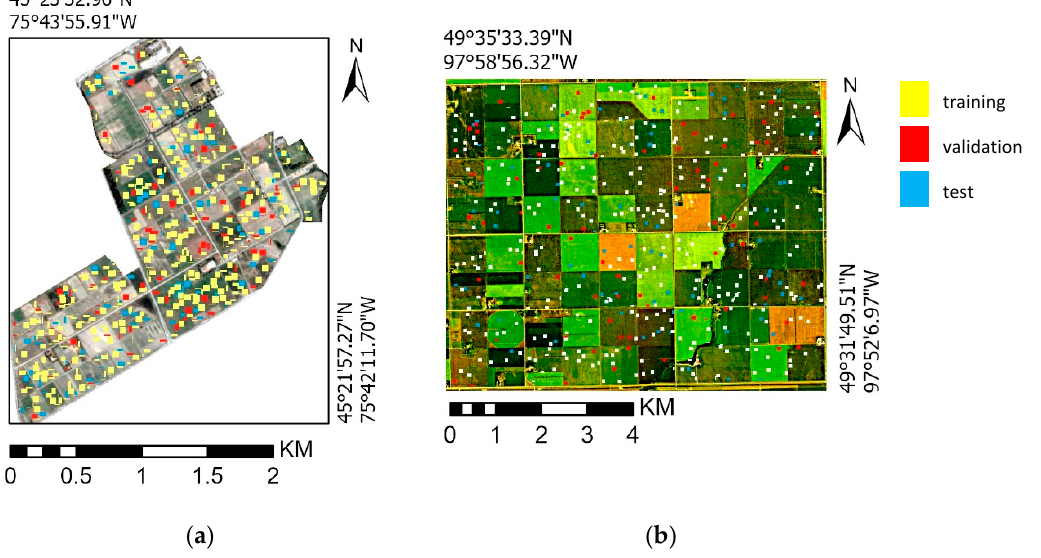
Figure 1. Study area and the true color composite images of ( a ) CEF (acquired on 3 July 2018) and ( b ) Winnipeg (14 July 2012) datasets, along with distributions of training, validation, and test sets.